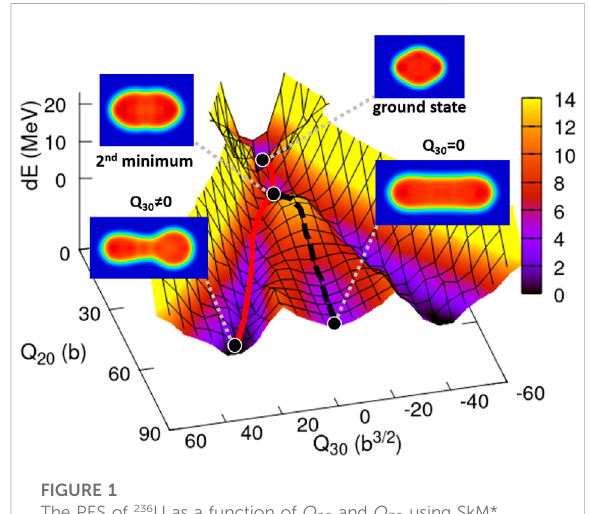
FIGURE 1 The PES of 236 U as a function of Q 20 and Q 30 using SkM* parameter